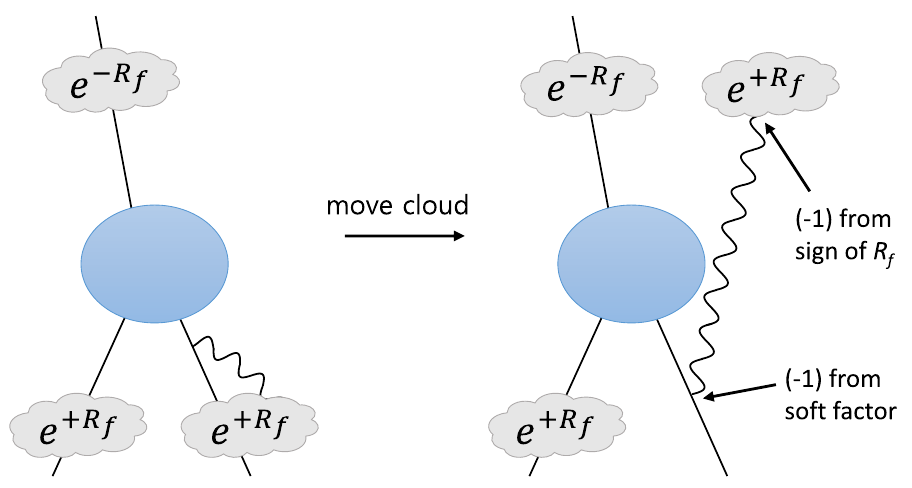
Figure 2. An example of an incoming cloud being moved to the out-state. Each boson connecting this cloud to an external propagator obtains two factors of ( (cid:0) 1), one from the soft factor and the other from the \wrong" sign of R f . These two factors cancel, and thus the overall amplitude is una(cid:11)ected by such a